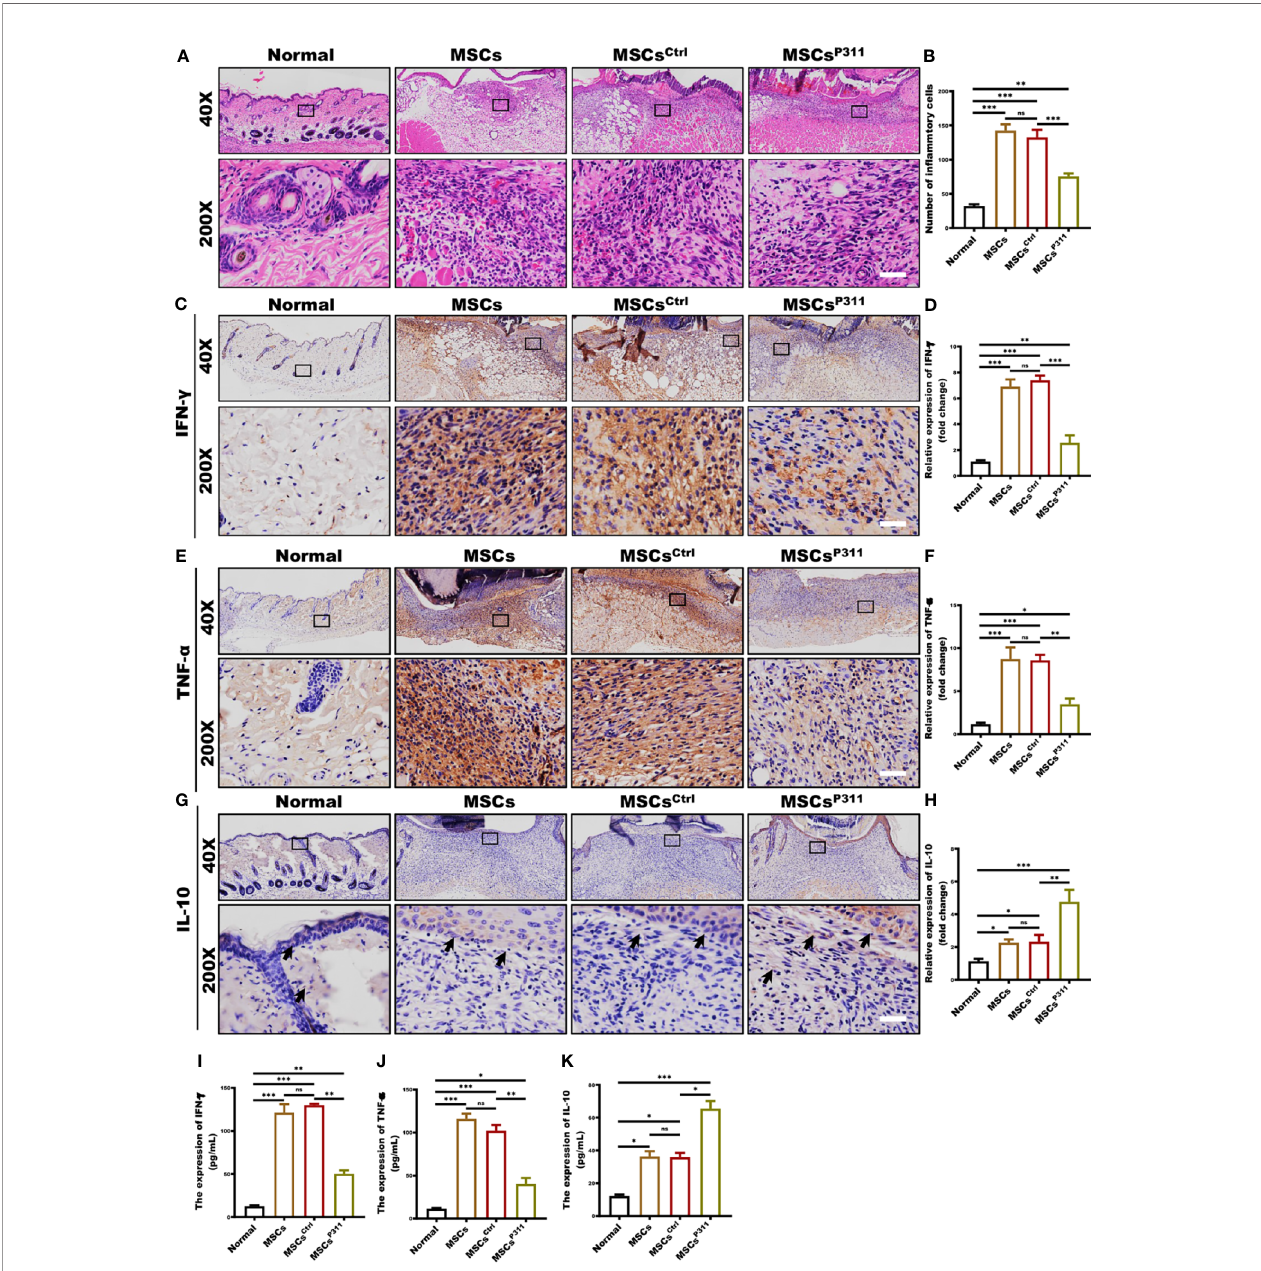
FIGURE 2 | P311 enhances the capability of MSCs-mediated improvement of in fl ammatory microenvironment in skin wound tissues. The immunological microenvironment of wound tissue was evaluated at day 3 post-injury by detecting the in fi ltration of in fl ammatory cells, production of pro-in fl ammatory cytokines, and expression of anti-in fl ammatory cytokine in normal mice and mice with MSCs, MSCs Ctrl , MSCs P311 administration (n=3/group). The in fl ammatory cell in fi ltration in granulation tissues was examined by H&E staining. (A, B) Representative H&E images of granulation tissues were shown (left panel), and in fl ammatory cells per visual fi eld were counted and statistically analysed (right panel). Scale bar: 50 µm. (C – F) Representative immunohistochemical images of IFN- g and TNF- a in granulation tissues were shown (left panel), and the expression of IFN- g and TNF- a was statistically analysed (right panel). Scale bar: 50 µm. (G, H) Representative immunohistochemical images of IL-10 in granulation tissues were shown (black arrows) (left panel), and the expression of IL-10 was statistically analysed (right panel). Scale bar: 50 µm. Supernatants of wound tissue extract at day 3 post-injury were applied for identifying the content of IFN- g (I) and TNF- a (J) in mice with MSCs, MSCs Ctrl , MSCs P311 treatment by means of ELISA. (K) Supernatants of wound tissue extracted at day 3 post-injury were applied for identifying the contents of IL-10 in mice with MSCs, MSCs Ctrl , MSCs P311 treatment by means of ELISA. Scale bar: 50 µm. Data are representative of at least three independent experiments and represent mean ± SD of indicated number of mice per group. (ns, no statistical signi fi cance; *P < 0.05, **p < 0.01; ***p <